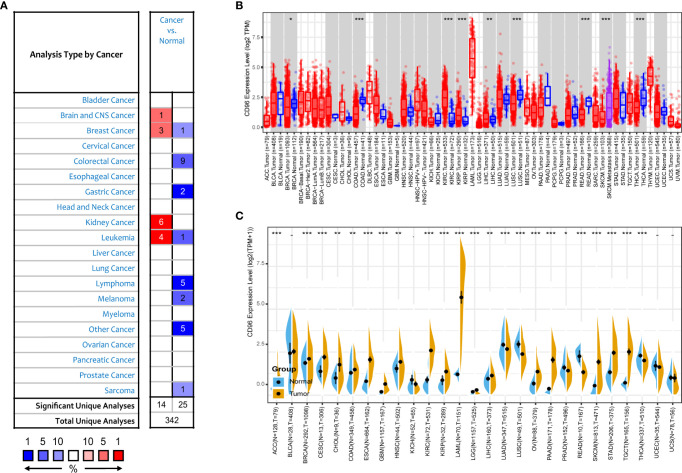
CD96 expression levels in different types of human cancers. (A) Increased or decreased CD96 in datasets of different cancers compared with normal tissues in the Oncomine database. (B) CD96 expression levels in different tumor types from TCGA database were analyzed by TIMER2.0 (*P < 0.05, **P < 0.01, ***P < 0.001). (C) Comparisons of CD96 expression levels between tumor tissues from TCGA database and normal tissues from GTEx database (*P < 0.05, **P < 0.01, ***P < 0.001).